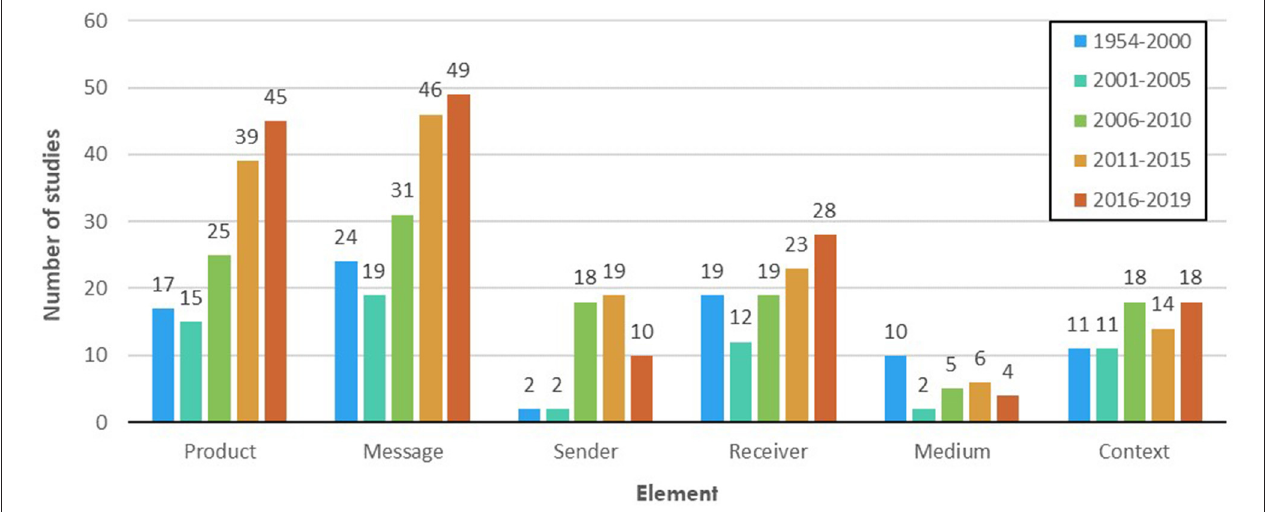
FIGURE 4 | Prevalence of empirical studies of each element (i.e., product, message, sender, receiver, medium, and context) during each period (i.e., 1954–2000, 2001–2005, 2006–2010, 2011–2015, and 2016–2019).